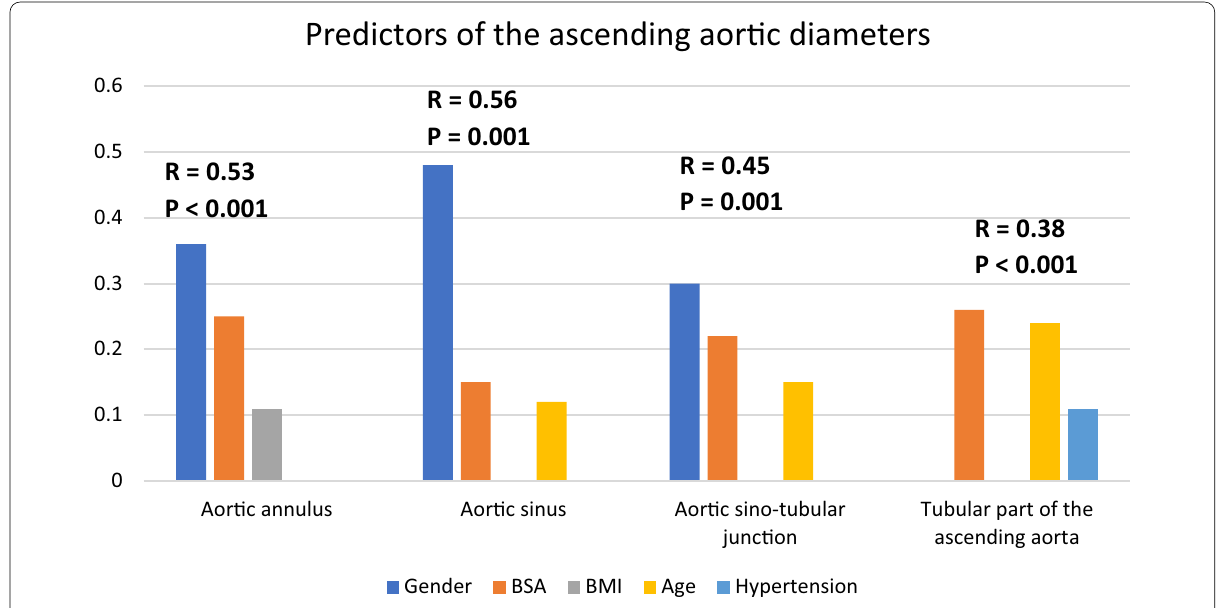
Fig. 10 Predictors of the ascending aortic diameters at its different